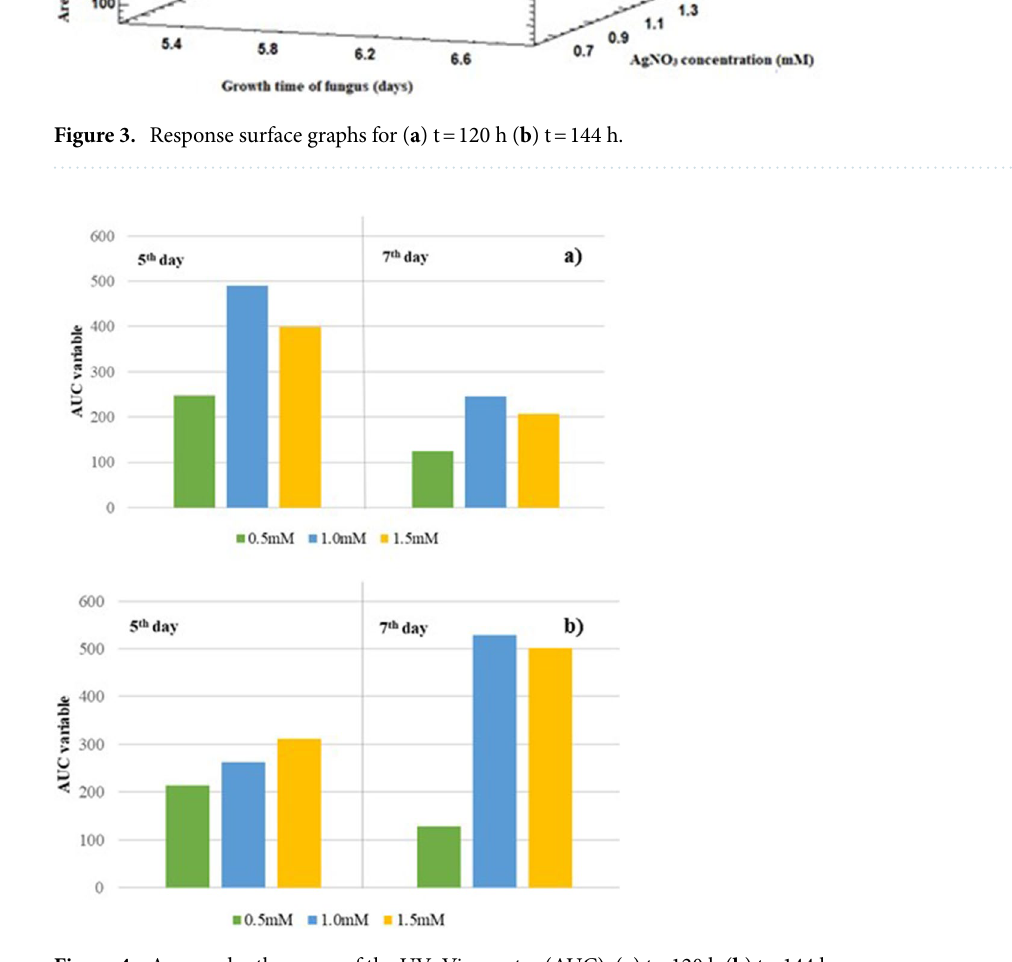
Figure 4. Area under the curve of the UV–Vis spectra (AUC). ( a ) t = 120 h ( b ) t = 144